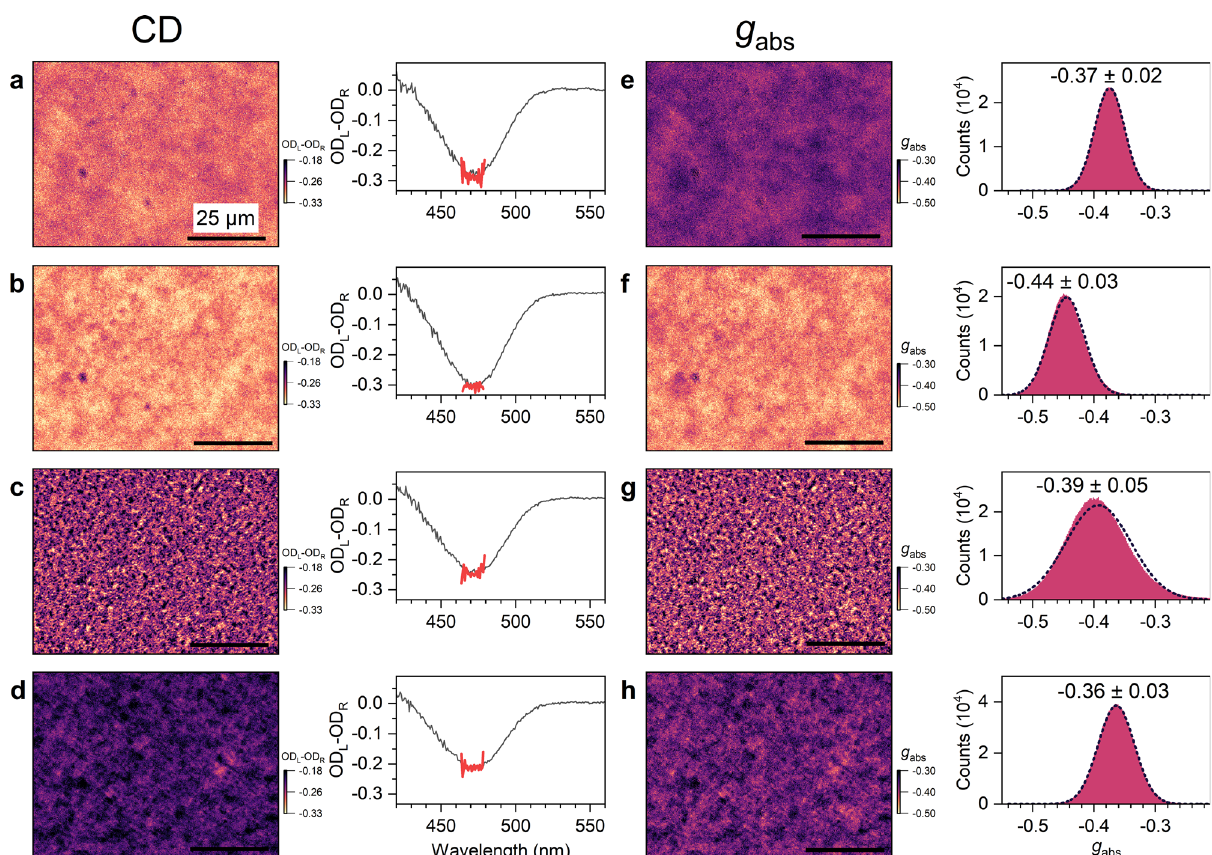
Fig. 3 CD imaging with diffraction-limited resolution for different regions of another c-PFBT thin fi lm. a – d Microscope images (80 × 60 μ m 2 ) for the circular dichroism of the c-PFBT thin fi lm at different positions. Plots on the right show the CD signals integrated over the entire fi eld of view (210 × 160 μ m 2 , thin black lines: full spectra, thick red lines: spectral region selected by the bandpass fi lter at 470 nm used for CD imaging). e – h Corresponding images for the dissymmetry factor g abs , with histograms on the right including Gaussian fi ts as dashed black lines, determined over the entire fi eld of view. The length of the black scale bar in each image indicates a distance of 25 μ m. Variations in counts in the g abs distributions are due to the different bin sizes